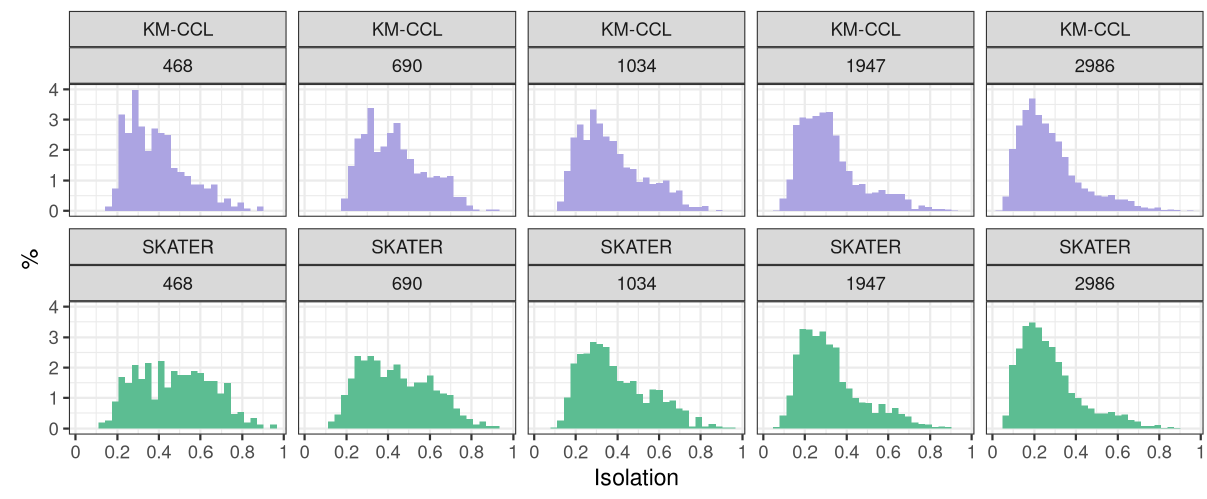
Figure 5. Distributions of the isolation metric values (the larger the better) for various number of regions created using the KM-CCL (top row), and the SKATER approach (bottom